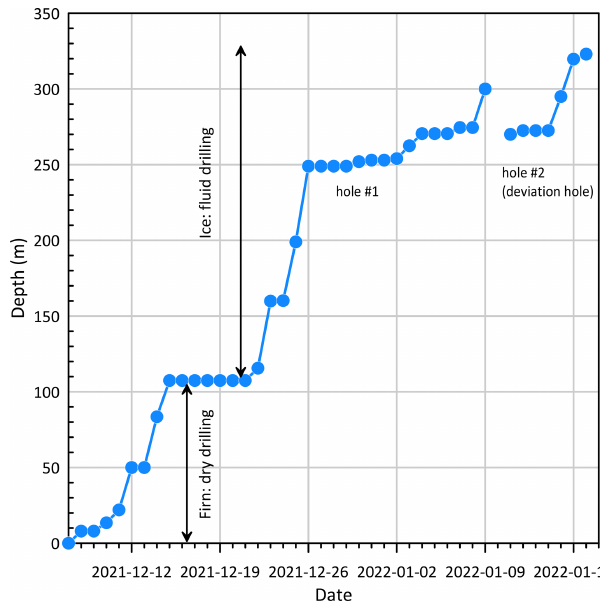
Figure 13. Little Dome C 2021/22 drilling progress.